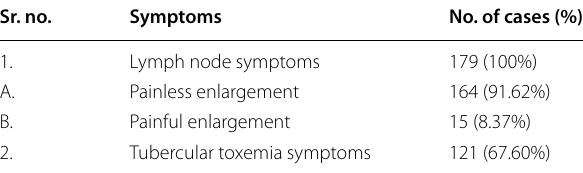
Table 2 Symptoms in patients’ cases with TB lymphadenitis Sr. no.